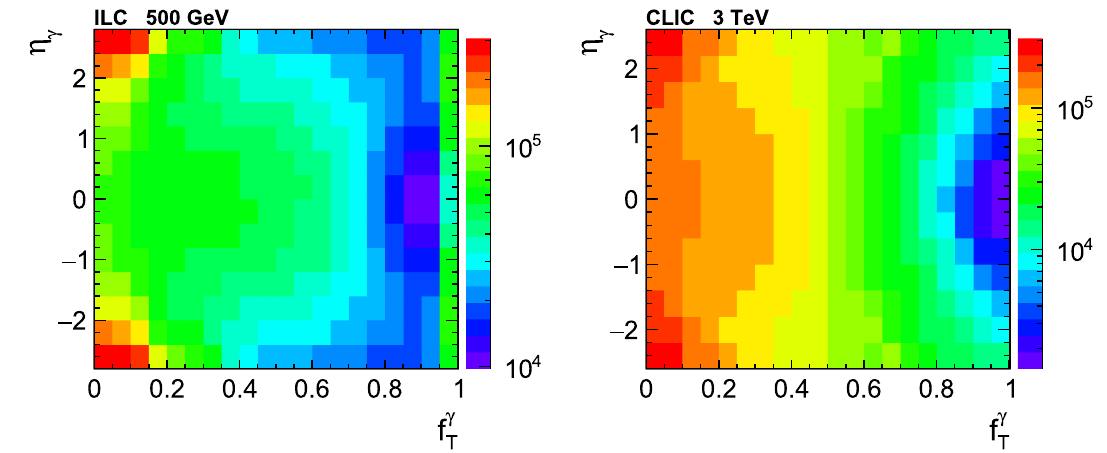
Fig. 7 Pseudorapidity vs transverse momentum fraction for mono-photon background events at 500GeV ILC (left) and 3TeV CLIC (right). Standard model expectations are normalised to integrated luminosity of 1600fb − 1 for ILC running with − 80%/+30% electron/positron beam polarisation and 1000fb − 1 for CLIC running with − 80% electron beam polarisation